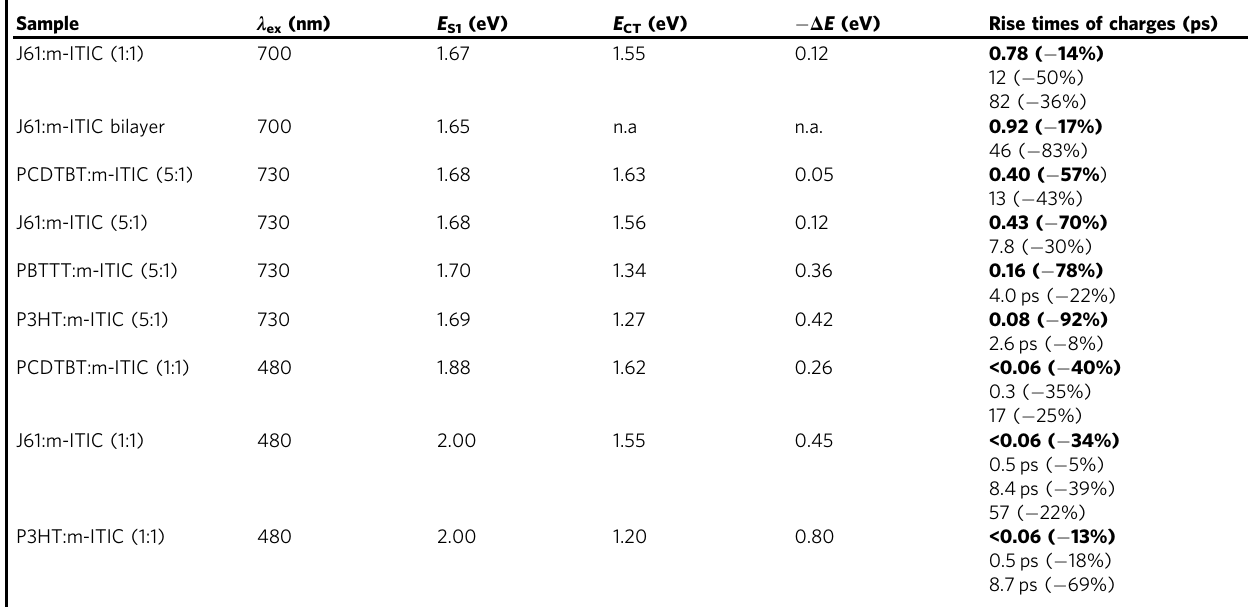
Table 1 Charge-transfer rates for different driving